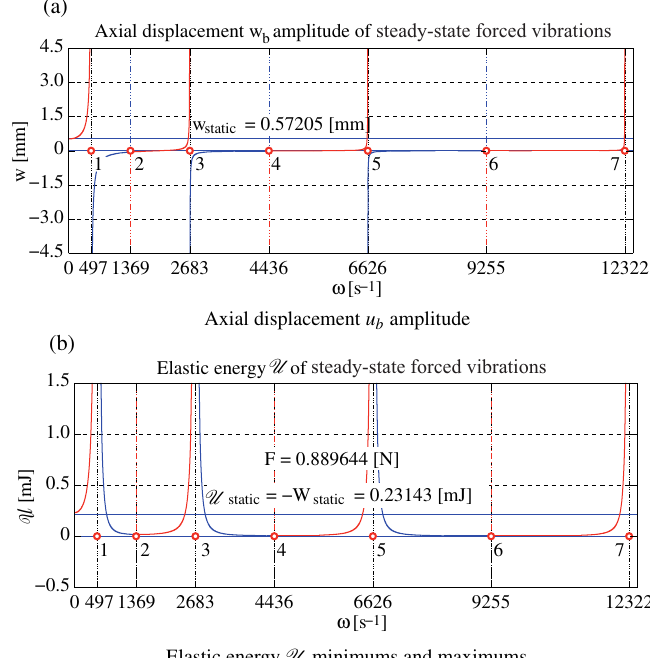
Fig. 10. Steady-state frequency response curves of fixed-fixed beam.